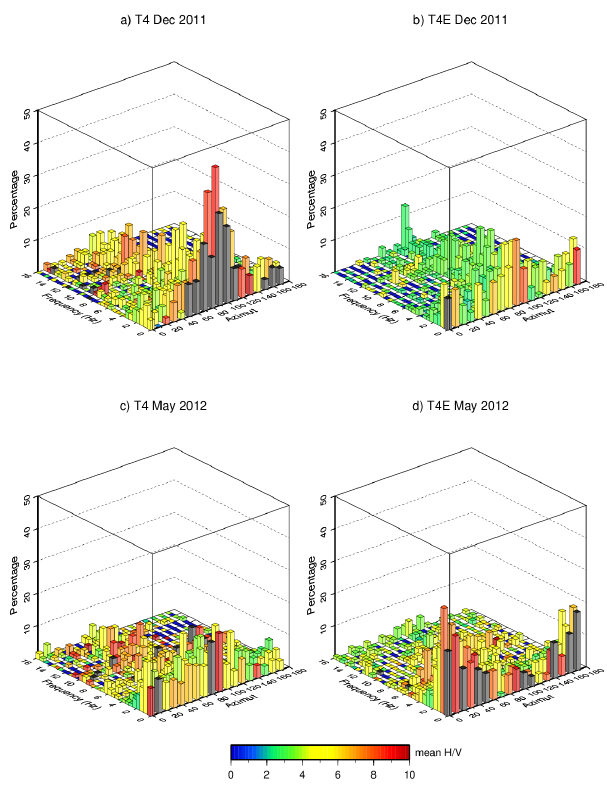
Fig. 11. Histograms of DHVPOR values relative to noise measure- Fig. 11 - Histograms of DHVPOR values relative to noise measurements carried out at sites T4 and 2 ments carried out at sites T4 and T4E (Colle Alto hill) in Decem- T4E (Colle Alto Hill) on December 2011 and May 2012. 3 ber 2011 and May 2012.